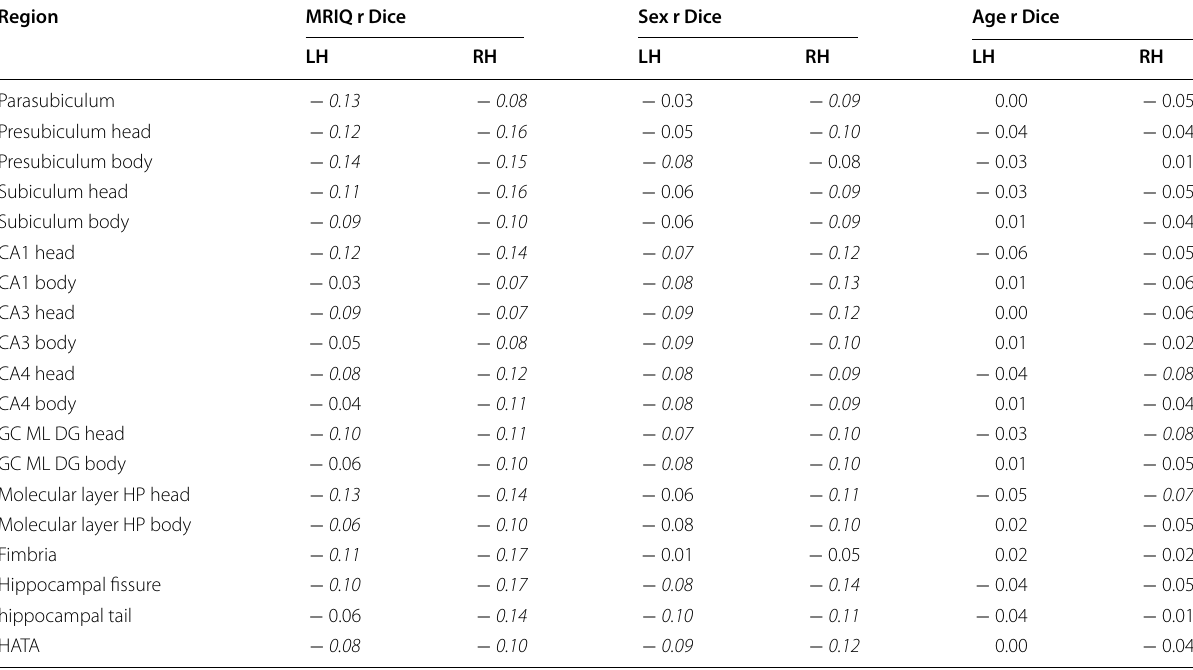
These were completed for left hemisphere LH and right hemisphere RH Correlations with p < 0.05 are highlighted in Italic Subfield Abbreviations include: Cornu Ammonis CA , Granule Cell and Molecular Layer of Dentate Gyrus GC-ML-DG , Hippocampus-Amygdala-Transition-Area HATA, Hippocampal Parcellation HP